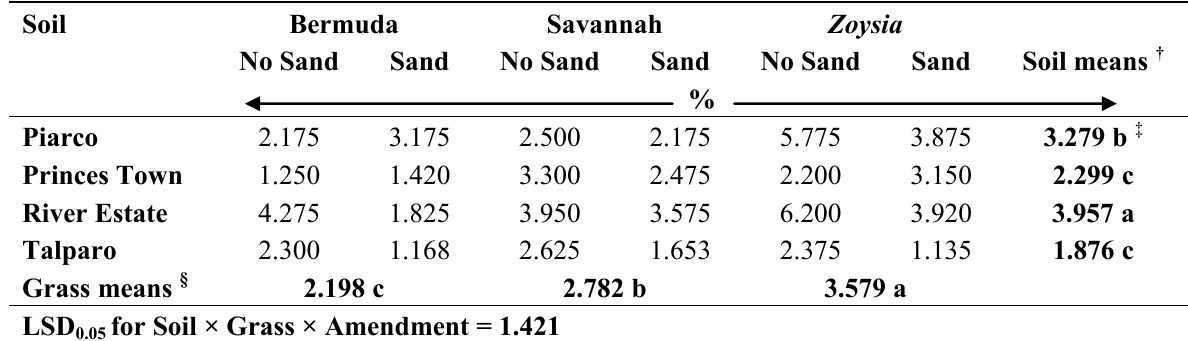
Table 10. Sand layering influence on NCPS across four soils and three turfgrasses.